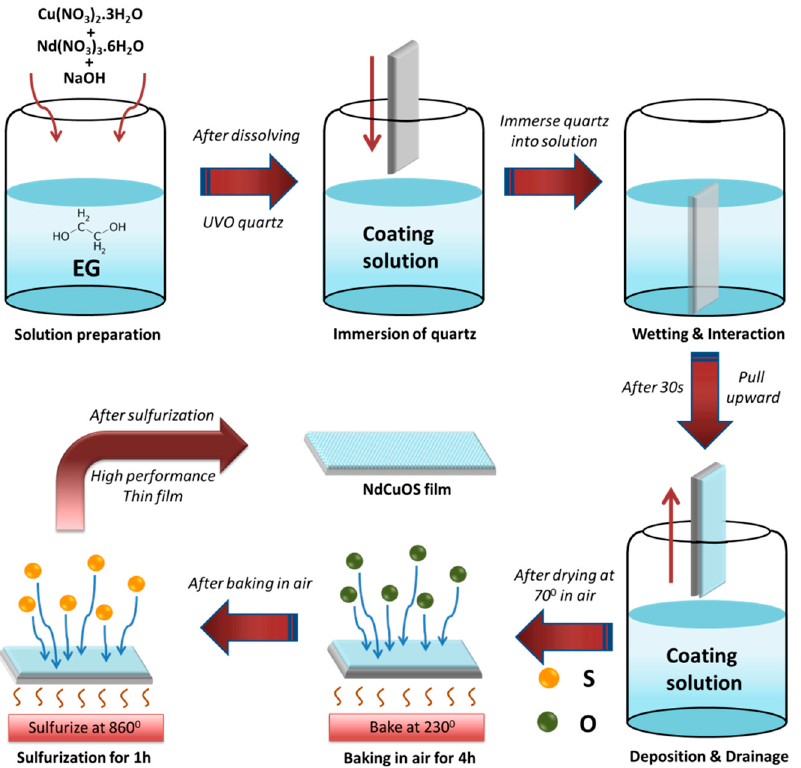
Figure 10. Schematic illustration of the solution-based (dip-coating) process with post-annealing to prepare NdCuOS film. Reproduced with permission from Ref. [189]. Copyright 2018 Elsevier.